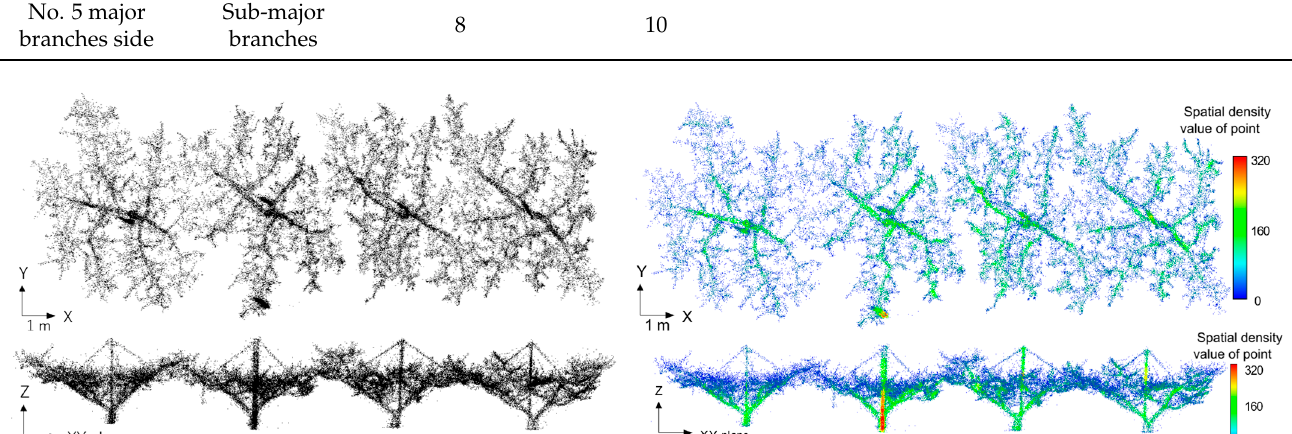
Figure 8. Before and after coloring the point cloud using a spatial density value calculating the number of points with a radius of 0.2 m in a spherical space: left —original point cloud model; right — the point cloud model colors using the spatial density value of the point.